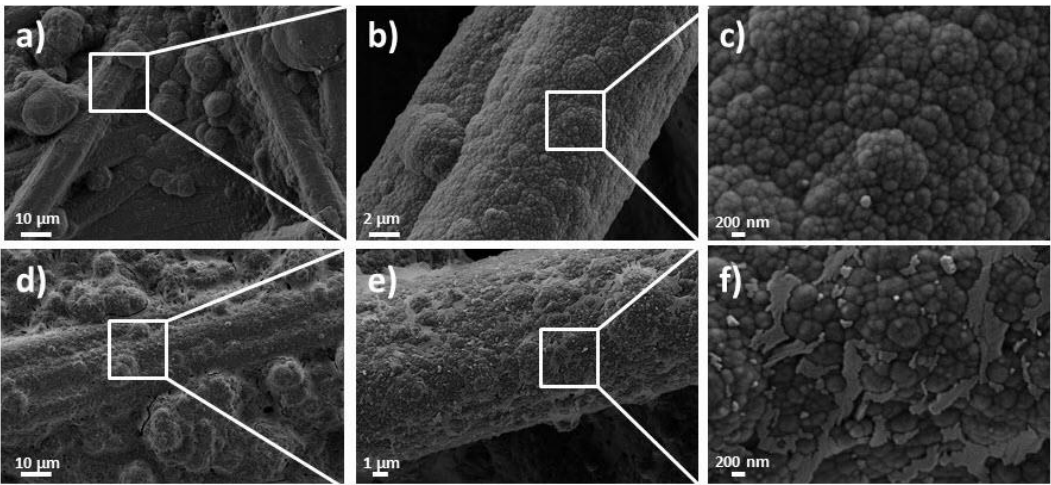
/ rGO B :CNT 2.5 at ( a – c ) zero cycles and ( d – f ) after 500